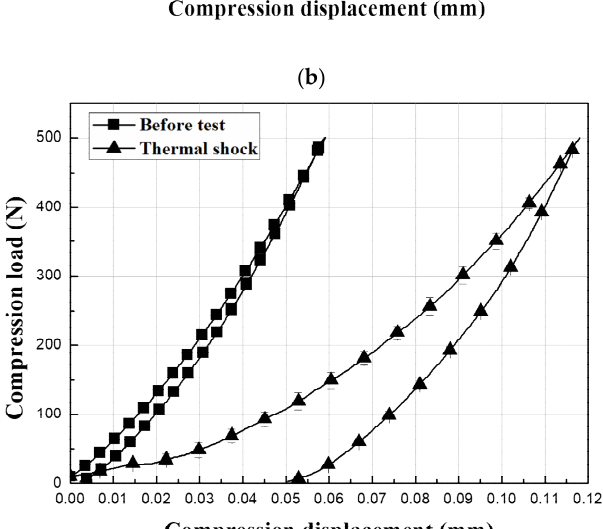
Figure 11. Hardness changes of EBC materials during thermal shock tests. 4. Conclusions The purpose of this study was to introduce an EBC to protect SiC f /SiC composites from high- temperature oxidation and corrosion and to investigate the durability of the coating when exposed to high temperatures and repeated thermal shocks. Crack formation, crack stability, and crack healing were investigated after specimens were subjected to repeated heating to 1350 °C followed by cooling. In addition, spherical post-indentation tests were performed to determine the change in mechanical behavior after thermal shock. As a result, the following conclusions were obtained: (1) EBC layers composed of mullite, mullite + Yb 2 SiO 5 , and Y 2 SiO 5 were coated via APS onto a Si bondcoat. The bondcoat was previously coated onto a SiC f /SiC composite. All of the coating